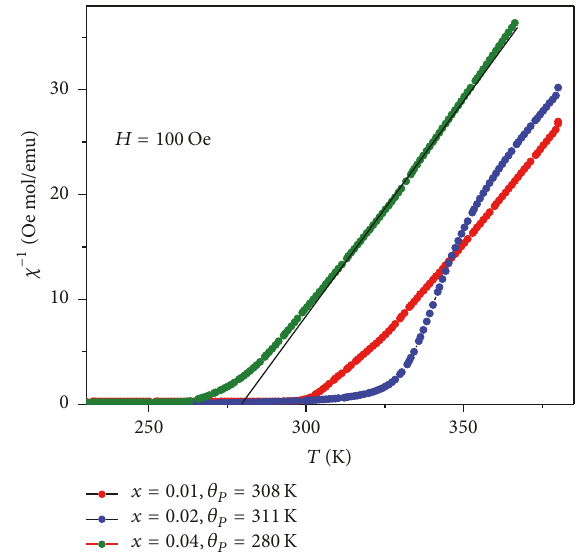
Figure 5: Temperature dependence of the inverse susceptibility in a field of 100Oe. The solid line is the fitting according to the Curie- Weiss